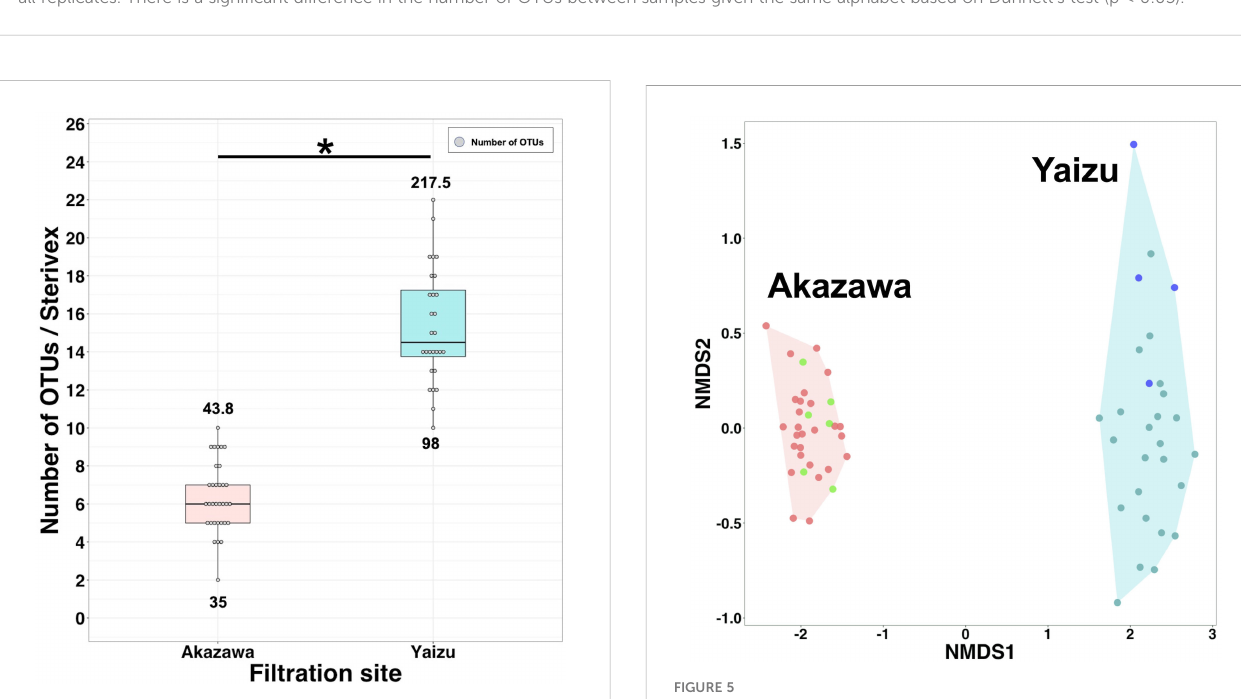
FIGURE 4 Number of fi sh OTUs obtained from pumped deep-sea water sampled in Akazawa and Yaizu. Filtration volume of samples from Akazawa and Yaizu was 20 L and 10 L, respectively. Boxplots with circles indicate the number of OTUs. Upper and lower values indicate the alpha diversity (ChaoI index) and total number of OTUs, respectively. Asterisk indicates signi fi cant difference in number of OTUs between Akazawa and Yaizu samples based on Mann – Whitney ’ s test (p < 0.05).